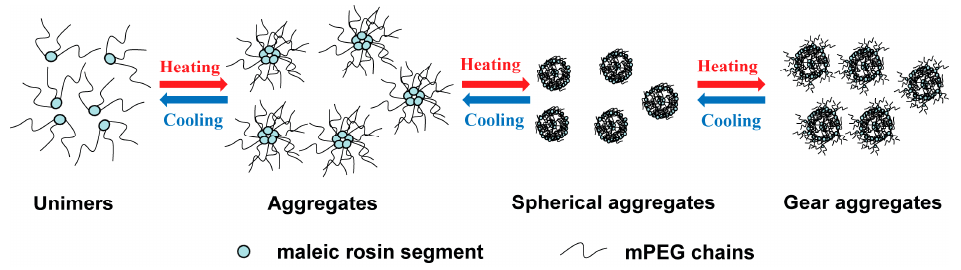
Figure 11. Evolution of structural transformation and aggregation of mPEG-maleic rosin chains during heating and cooling processes.